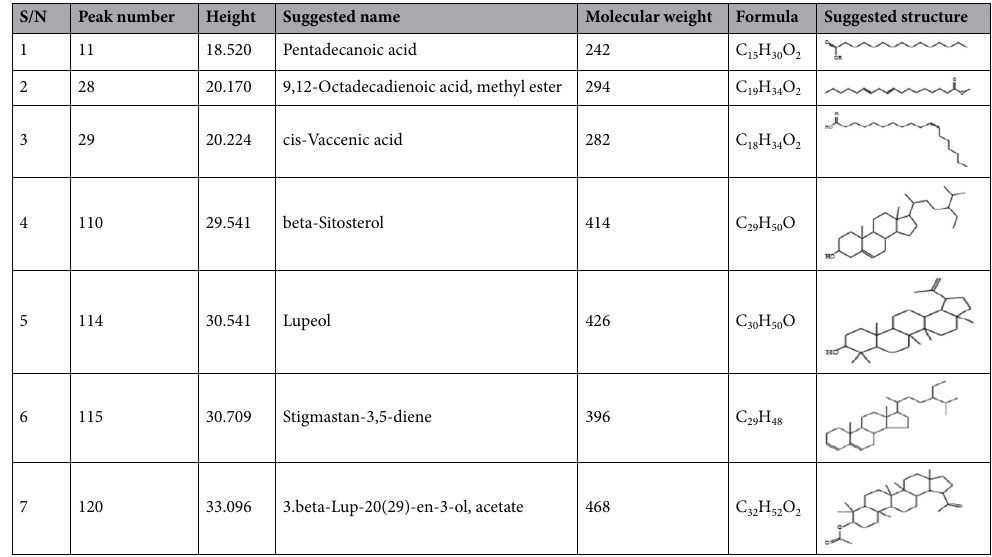
Table 3. Most abundant compounds present in dichloromethane fraction of Diospyros mespiliformis.